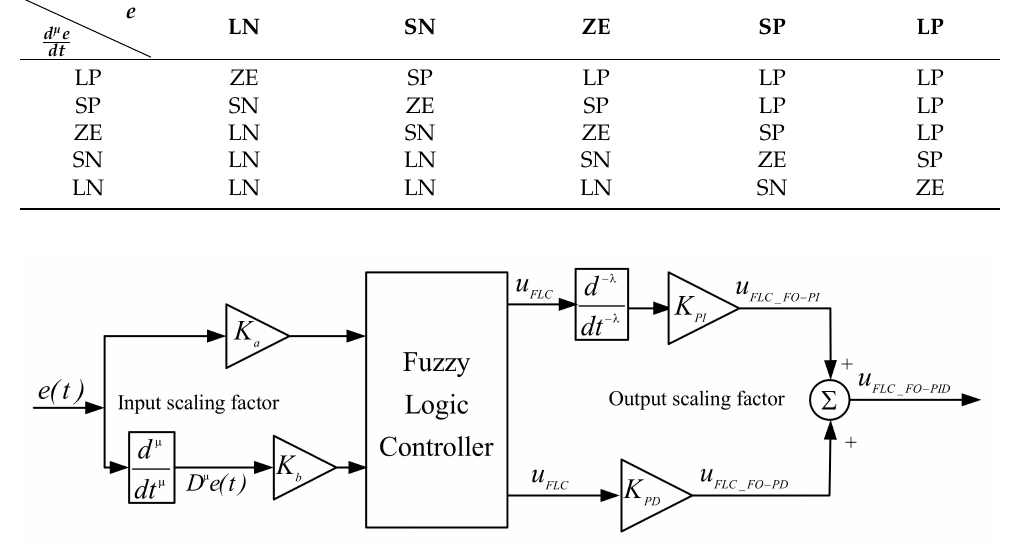
Figure 4. Representation of FO based fuzzy PID